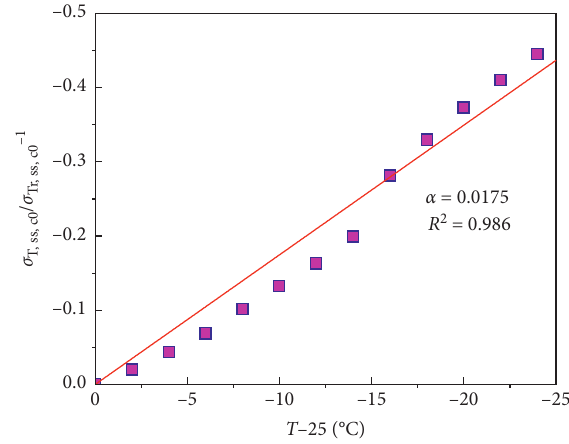
Figure 3: Temperature